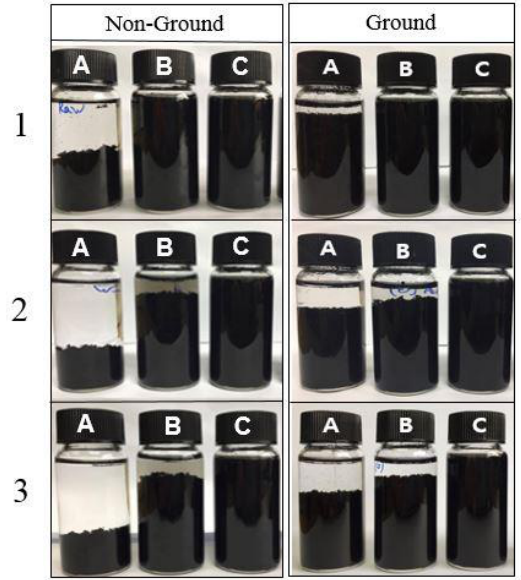
Figure 1. Sedimentation of the CNT nanofluid over time. (1) After sonication, (2) after 7 days, (3) after 30 days. Reprinted from ref. [37].